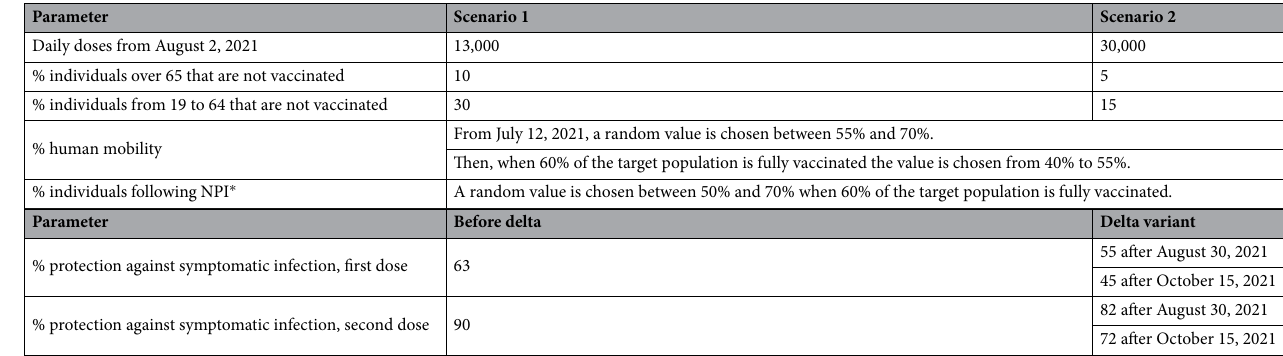
∗ Personal protection measures such as mask use, washing hands and keeping